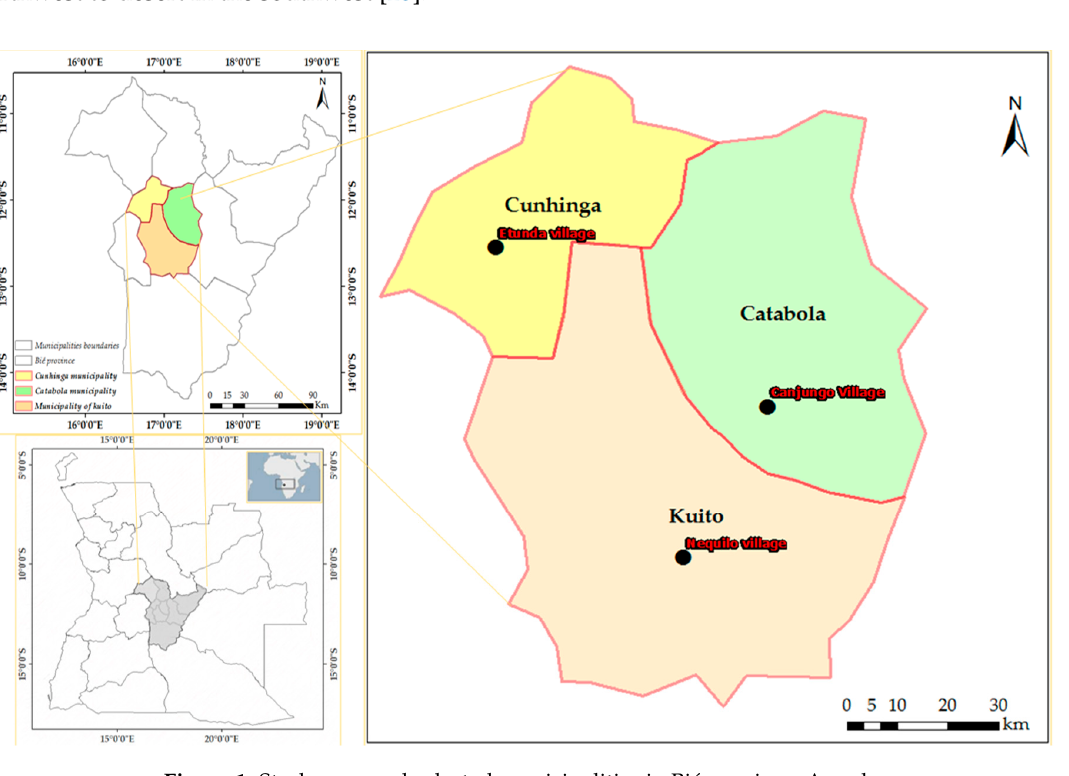
Figure 1. Study area and selected municipalities in Bié province–Angola.